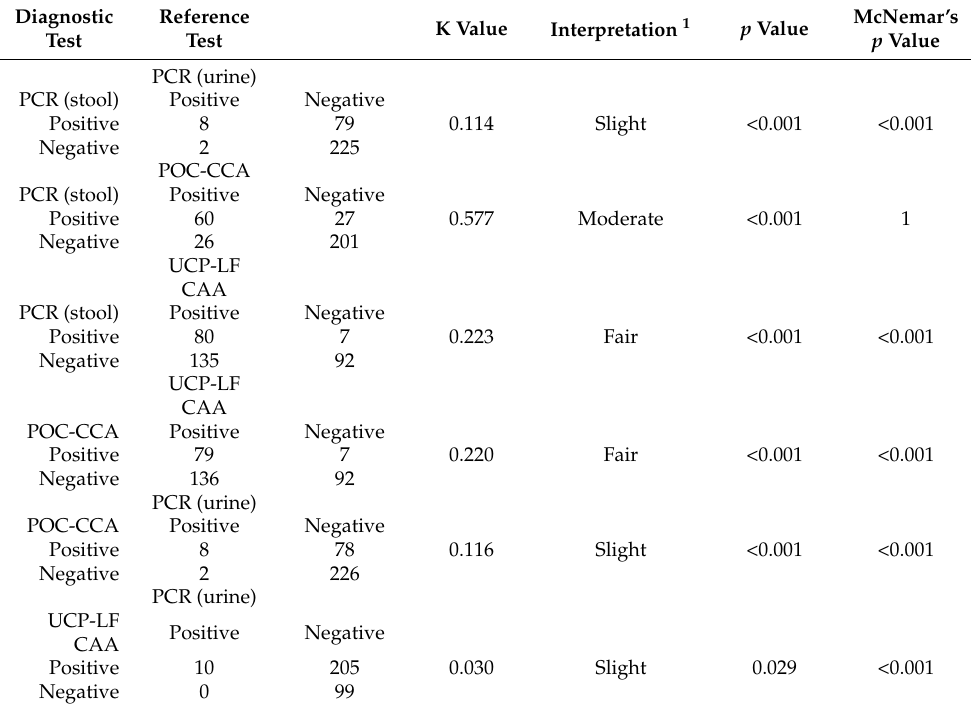
Table 2. The level of agreement between polymerase chain reaction (PCR) in urine and stool, point-of-care circulating cathodic antigen (POC-CCA), and the up-converting particle, lateral flow circulating anodic antigen (UCP-LF CAA) urine test by Cohen’s κ coefficient and McNemar’s χ 2 test in 314 individuals.